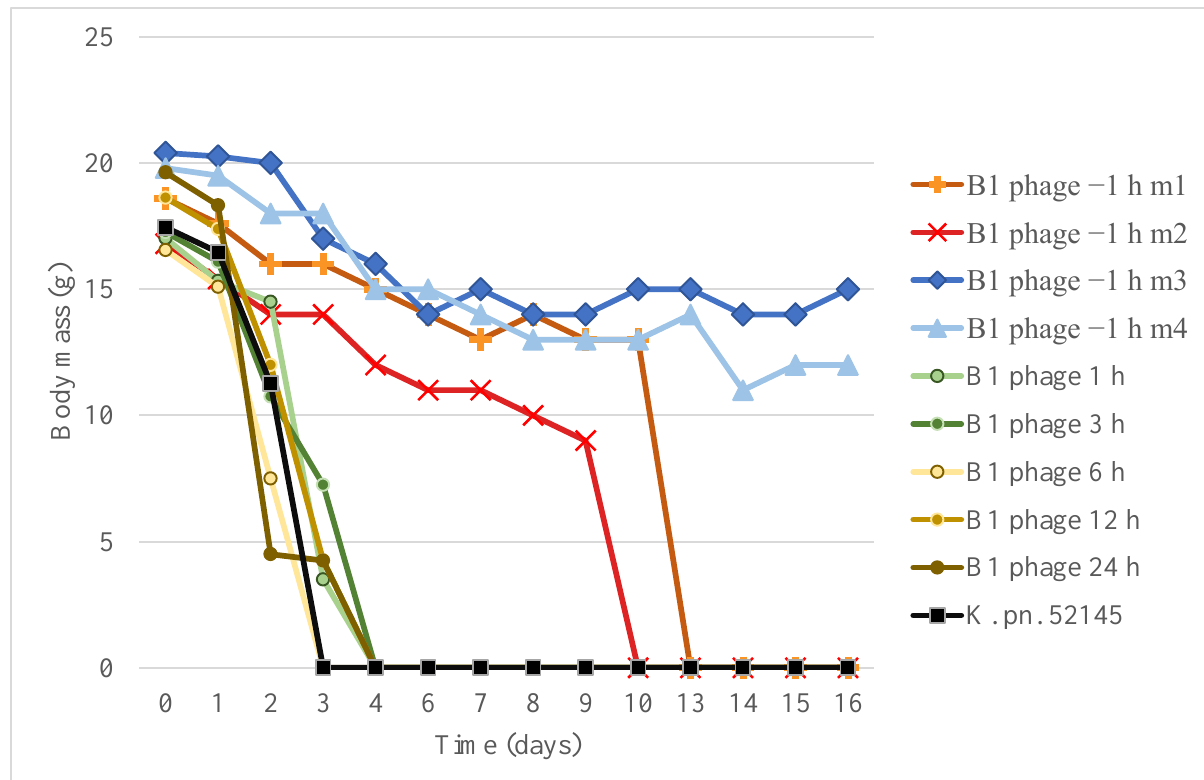
Figure 7. Comparison the therapeutic and preventive effect of B1 phage in frame of survival and bodyweight in a murine nasal infection model. The graph shows body mass of mice from the start of nasal cavity infection over 16 days. Body mass in groups of therapeutic phage administrations (B1 phage 1 h, 3 h, 6 h, 12 h, 24 h) and in the K. pneumoniae 52145 infection positive control (K. pn. 52145) are shown as the mean of four mice from the same group. Body mass graphs of mice in the preventive phage administered group (−1 h) are indicated individually (B1phage −1 m1, m2, m3, m4).